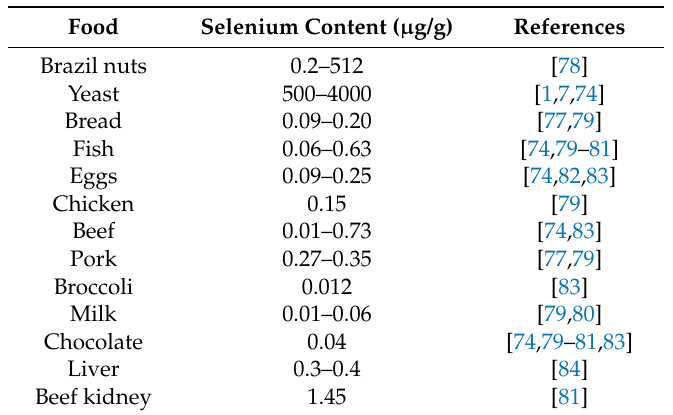
Table 3. Selenium content in selected food